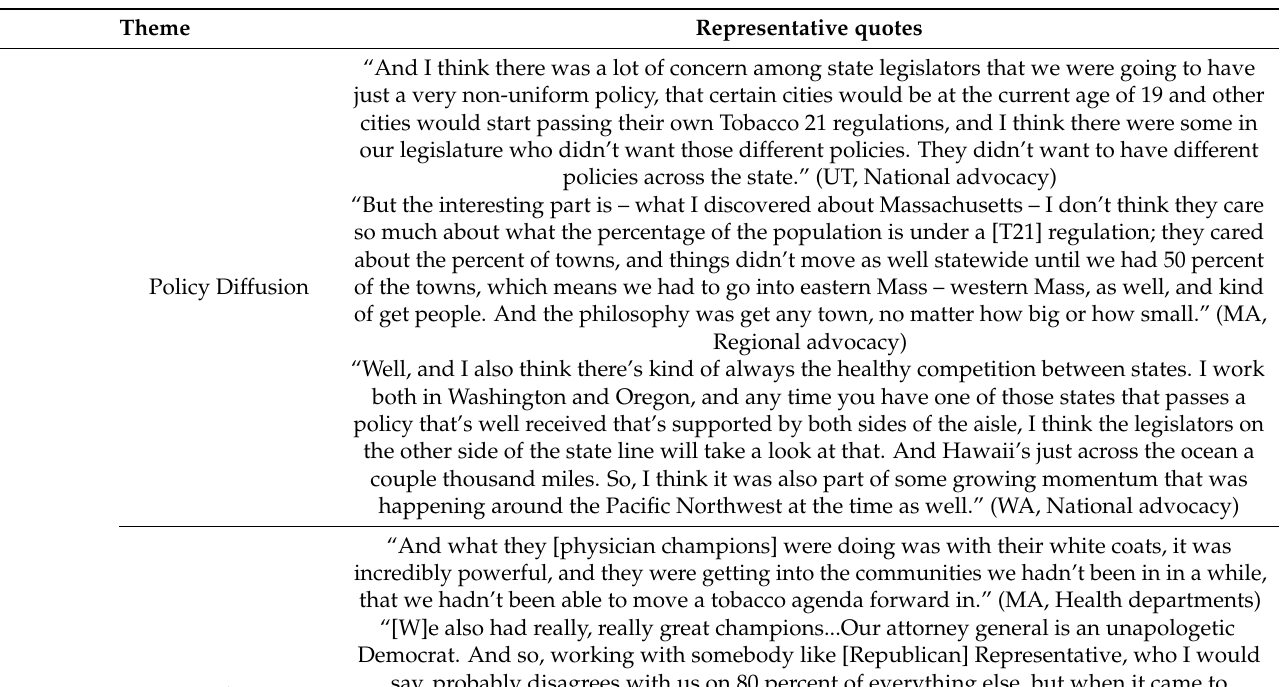
Table 3. Facilitators and barriers to passing T21